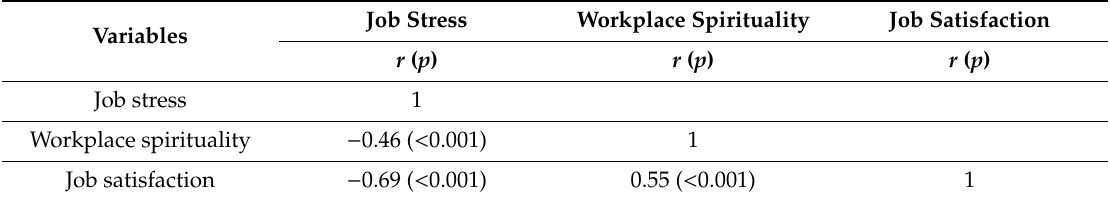
Table 3. Correlation between job stress, workplace spirituality, and job satisfaction ( N =